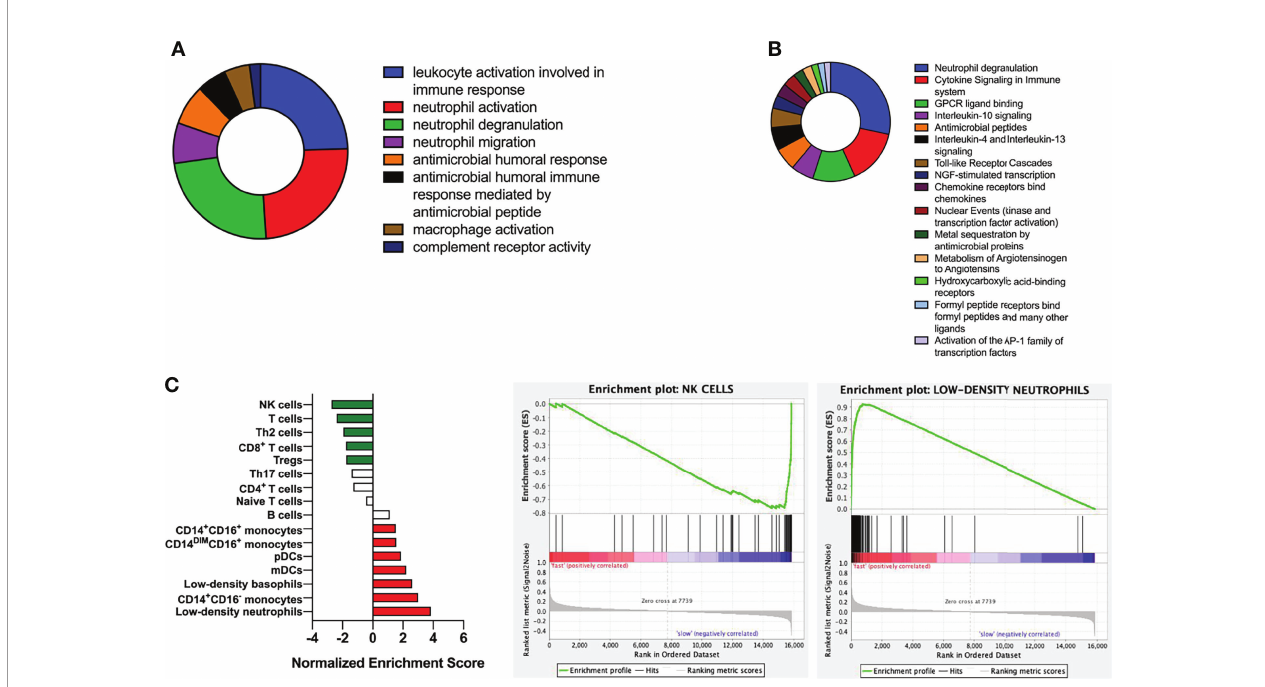
FIGURE 4 | Functional and pathway enrichment analysis of DEGs. (A) Analysis of biological functions using GO enrichment. (B) Pathway analysis using KEGG. (C) Gene enrichment analysis; Kolmogorov-Smirnov test was used to calculate P-values.